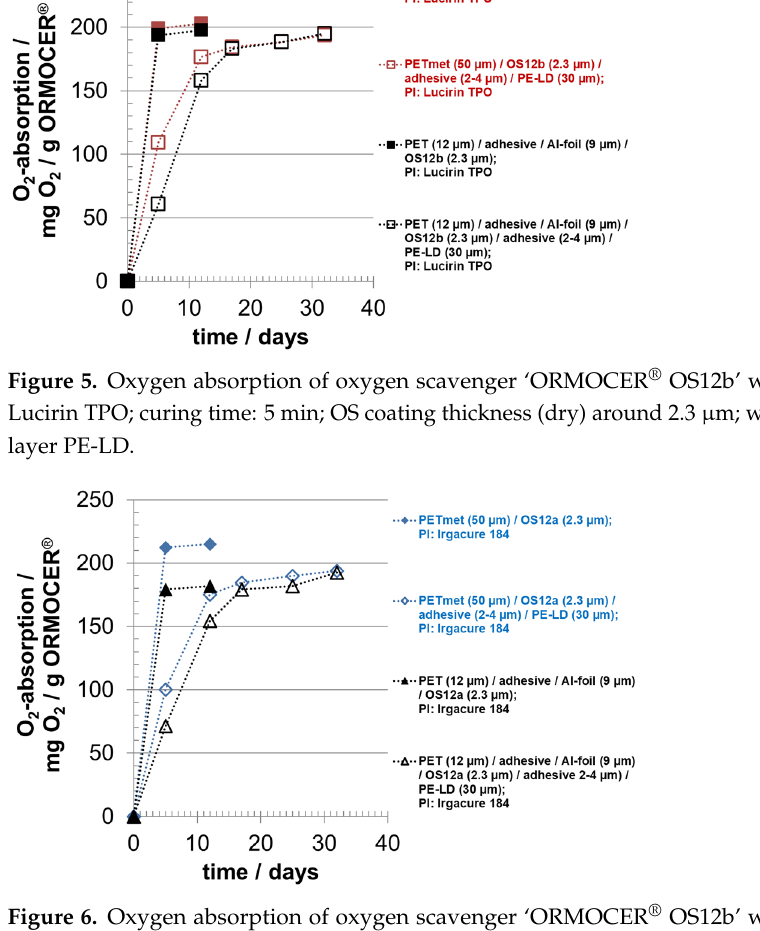
Figure 6. Oxygen absorption of oxygen scavenger ‘ORMOCER ® OS12b’ with photo-initiator (PI) Irgacure 184; curing time: 5 min; OS coating thickness (dry) around 2.3 µm; with and without sealing layer PE-LD.